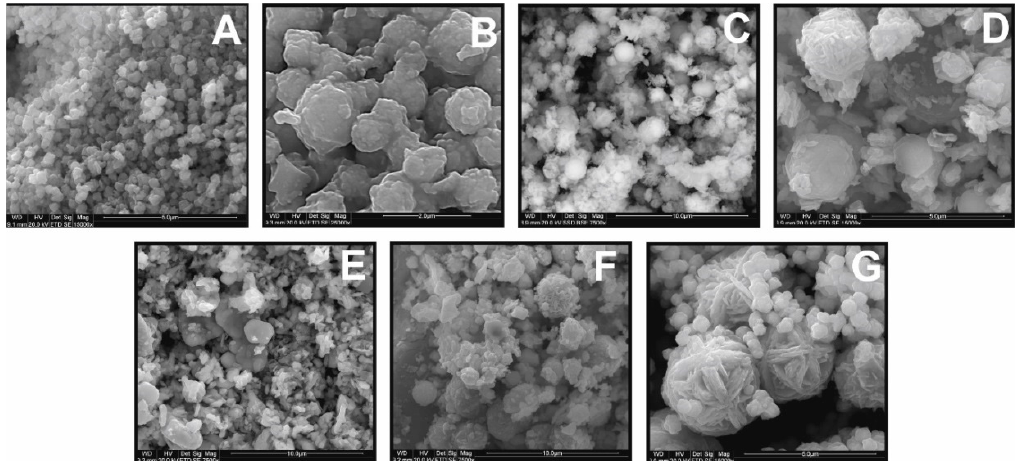
Figure 3. The effect of various EG:H 2 O ratios on the morphology of Cu 2 FeSnS 4 (CFTS) synthesized for 1 week at 195 °C: ( A ) 1:0; ( B ) 7:1; ( C ) 3:1; ( D ) 5:3; ( E ) 1:1; ( F ) 3:5; ( G ) 1:3 EG:H 2 O ratio. With the increase in the water content in the initial batch, two generations of crystallites appear. The optimal EG:H 2 O ratio is